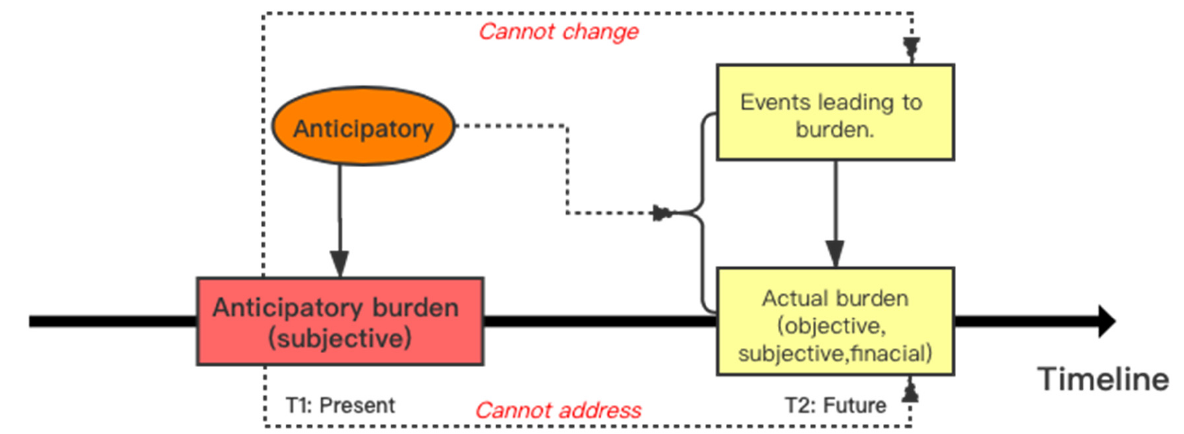
Figure 3. Theoretical model of anticipatory burden in adult-child caregivers.